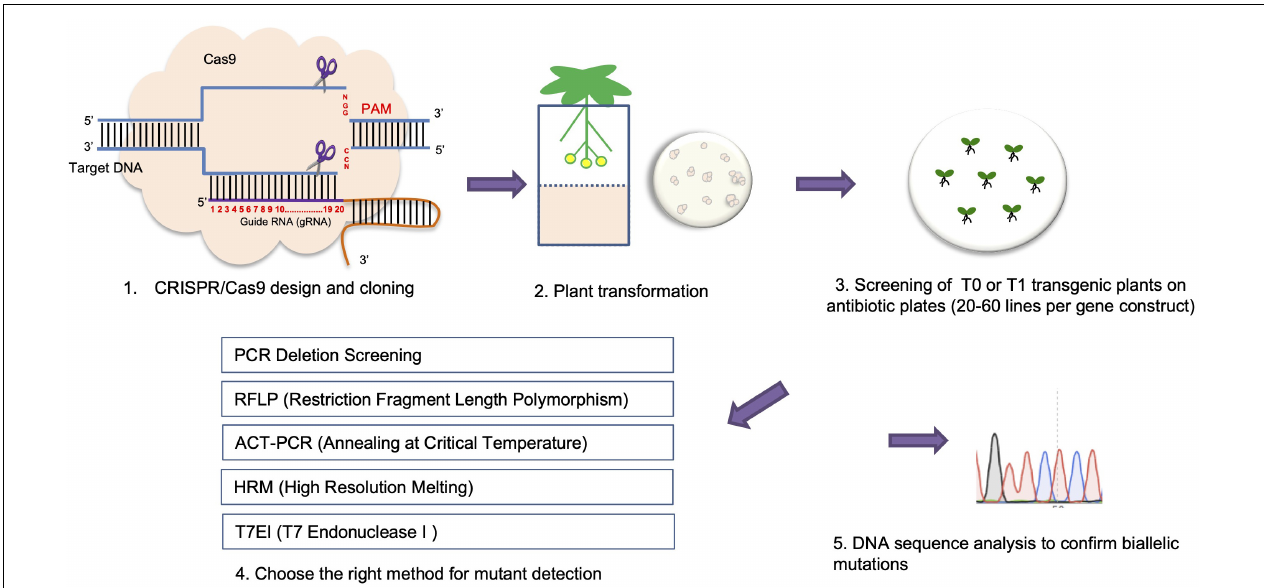
FIGURE 3 | A pipeline for using CRISPR/Cas9 mediated genome editing to generate plant knock-out mutants.